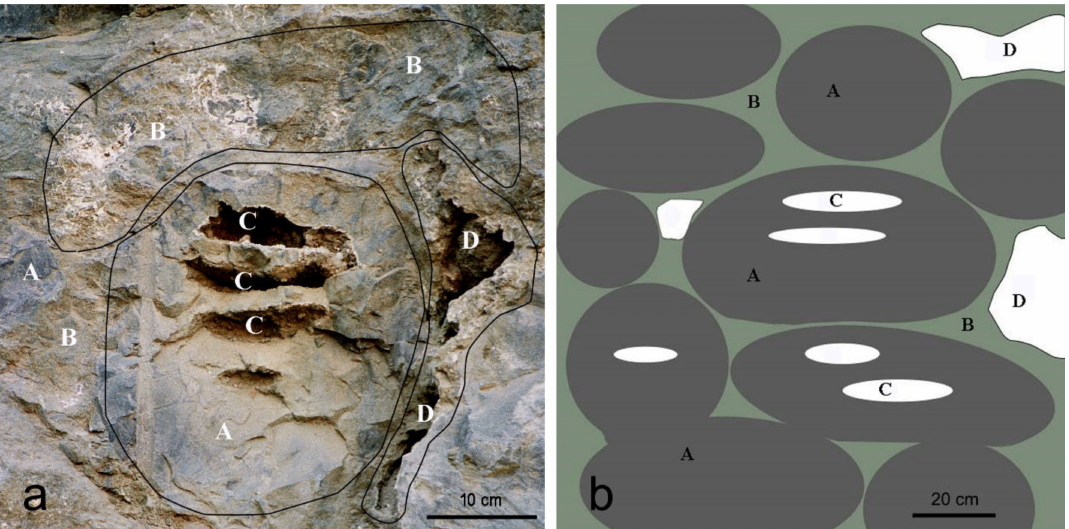
Figure 6. Cavities in a pillow and void spaces in the interpillow matrix. ( a ) Field photograph (section view) and ( b ) schematic sketch showing: (A) partly spilitized pillows, (B) interpillow matrix consisting of altered hyaloclastite breccia, (C) drained cavities within pillows, (D) void spaces.